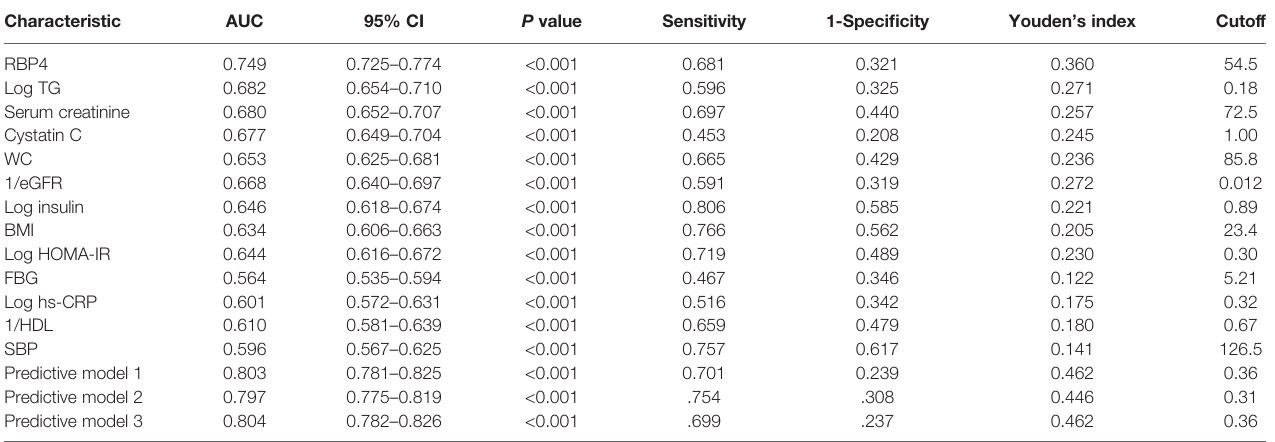
TABLE 5 | Predictive value of RBP4 and other indicators for hyperuricemia in the general population.